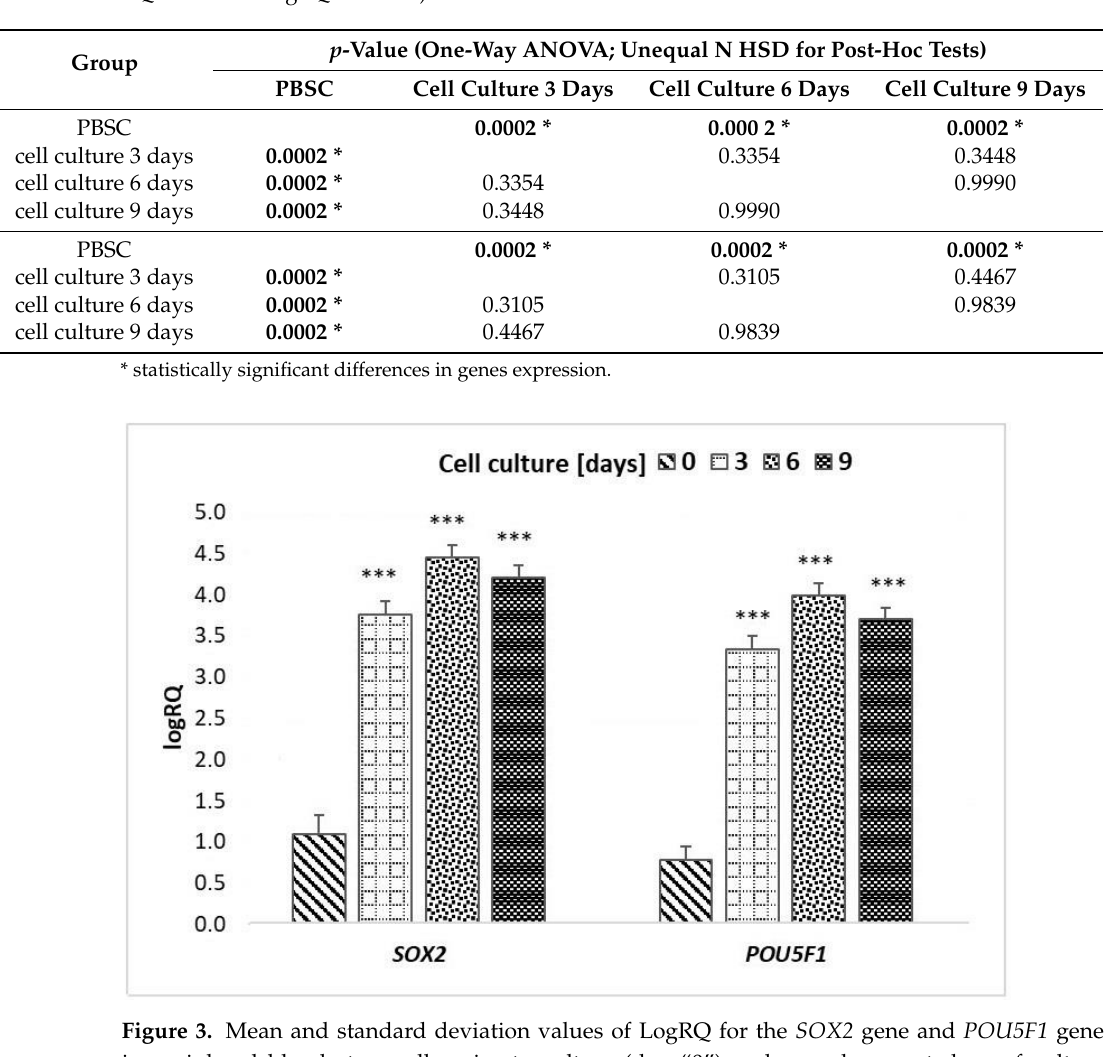
Table 2. One-way ANOVA p -value for compared CD34+ PBSC groups for the analyzed targets (log RQ SOX2 and logRQ POU5F1).